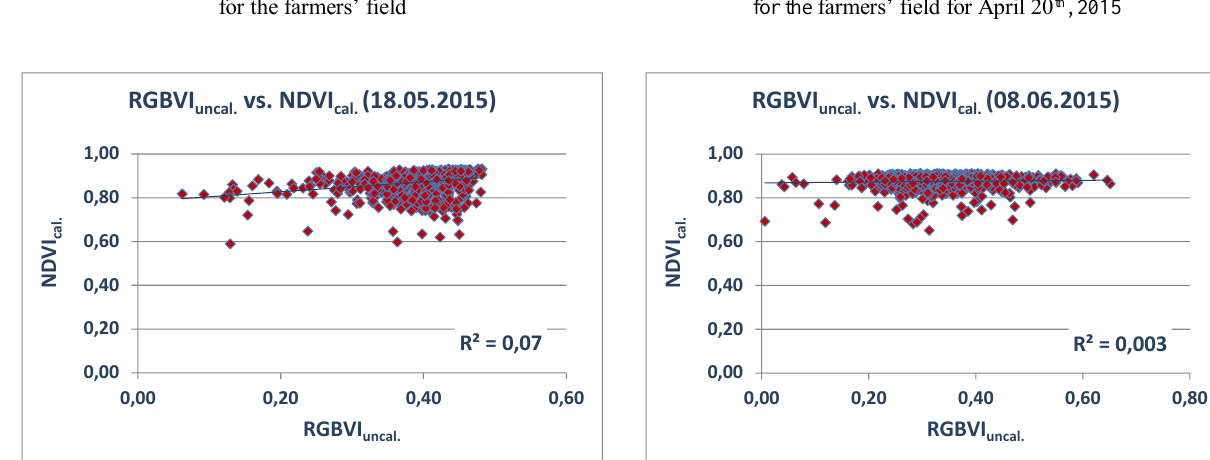
Figure 9. Evaluation of the RGBVI uncal. vs. NDVI cal. Figure 10. Evaluation of the RGBVI uncal. vs. NDVI cal.